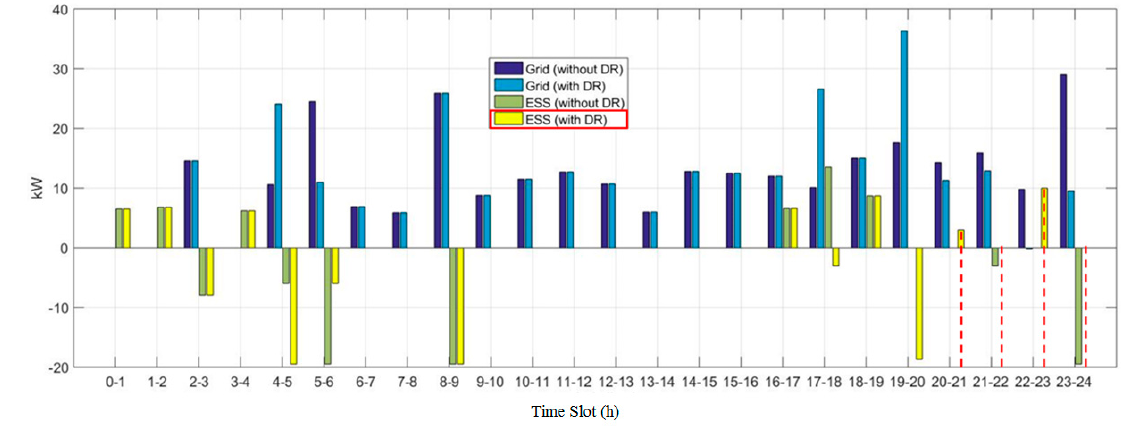
Figure 12. The application result of peak control.